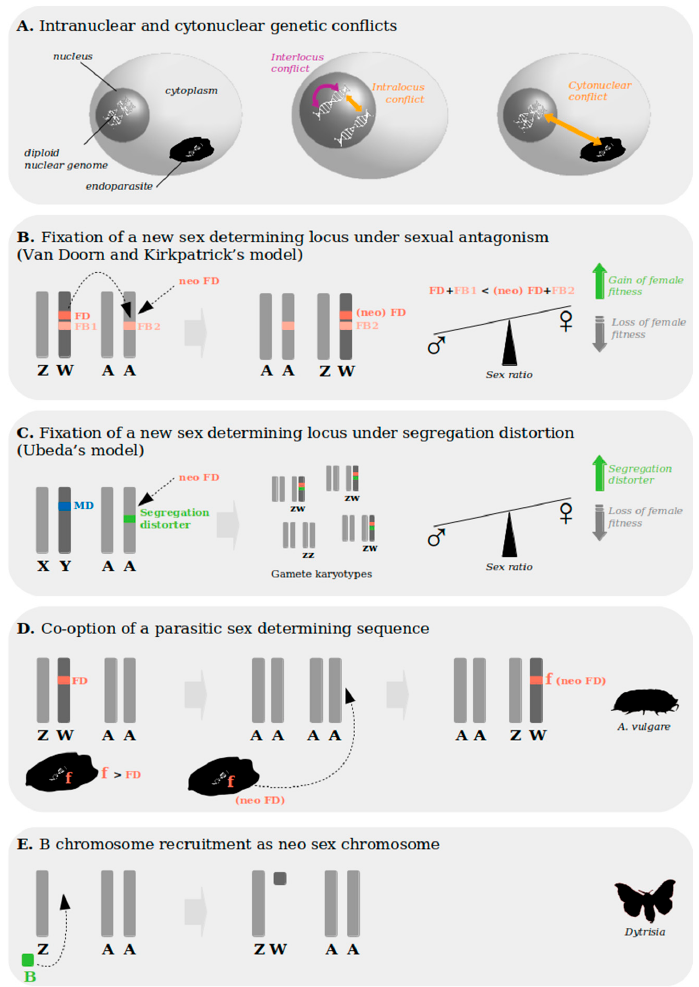
Figure 4. Intranuclear and cytonuclear genetic conflicts driving sex chromosome turnover. ( A ) Genetic conflicts can arise between elements within the nuclear genome (intranuclear conflicts) and affect alleles of a same locus (i.e., intralocus conflict) or genes from different locus (i.e., interlocus conflict). Alternatively, genetic conflicts can arise between the nuclear genome and cytoplasmic el- ements (e.g., coming from an endosymbiont): those are cytonuclear conflicts. ( B ) Van Doorn and Kirkpatrick’s model predicts that if a new [neo FD-“FD” standing for Female Determinant] (or a translocated) sex-determining gene arises close to a sexually antagonistic allele [FB2-“FB” standing for Female Beneficial] on an autosome [A], and if the new combination is stronger than the pre- existing one [FD + FB1 < neo (FD) + FB2], the new locus will be fixed, and a new pair of sex chromo- somes will emerge [88] ⁠ . In the represented case (of a neo ZW pair), this would induce a transitory phase of female biased sex-ratio, and this imbalance is reinforced by the gain of female fitness. ( C ) Ubeda’s model proposes that the de novo emergence of a new sex-determining gene [neo FD] on an autosome [A], can be fixed when it arises on a chromosome carrying a segregation distorter which involves a transitory biased sex-ratio [89] ⁠ : more ZW (female) than ZZ (male) gametes are pro- duced. In the represented case, the XY (with male determinant [MD]) to ZW (with [FD]) turnover is named “heterogametic change”. ( D ) Reproductive manipulators such as Wolbachia can induce the loss of the pre-existing host sex-determining gene [FD], and the recruitment of their own sex-deter- mining sequence on a neo pair of sex chromosomes (as observed in A. vulgare , [87,90] ⁠ ). ( E ): A supernumerary B chromosome from parasitic origin can be co-opted as neo sex chromosome (such as in dytrisian species from the Lepidoptera clade [64] ⁠ ).